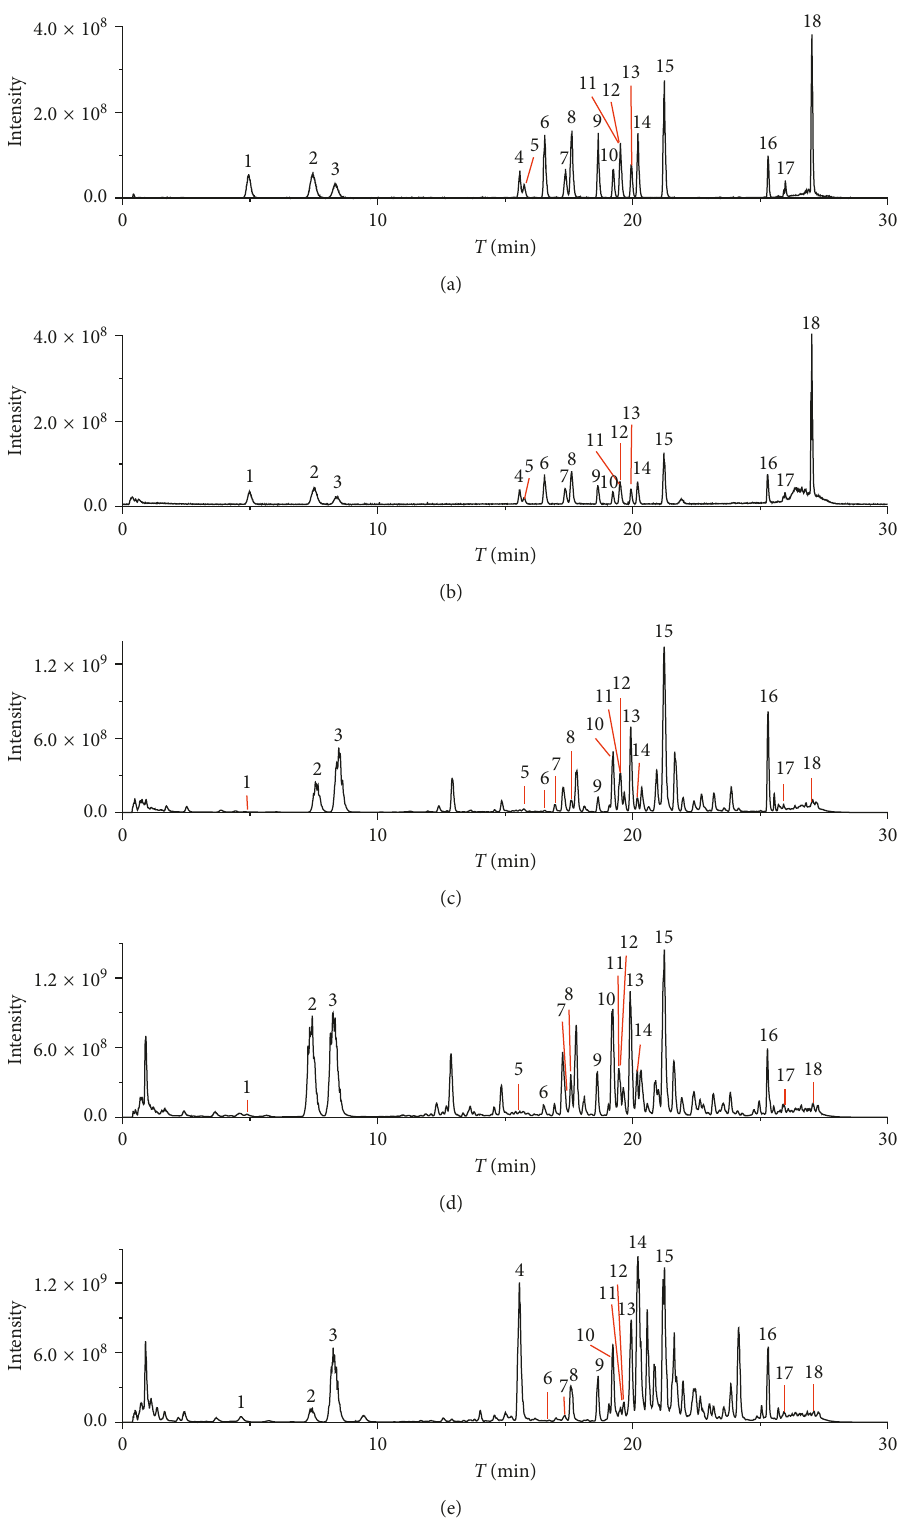
Figure 1: Total ion current chromatograms of eighteen ginsenoside standards based on (a) ion current chromatograms of (c) FGLS, (d) CGLS and (e) AMGLS based on ginsenoside Re; 4 pseudoginsenoside F11; 5 ginsenoside Rf; 6 notoginsenoside R2; 7 ginsenoside Rh1; 8 ginsenoside Rg2; 9 ginsenoside Rb1; 10 ginsenoside Rc; 11 ginsenoside F1; 12 ginsenoside Ro; 13 ginsenoside Rb2; 14 ginsenoside Rb3; 15 ginsenoside Rd; 16 ginsenoside F2; 17 ginsenoside Rg3; 18 ginsenoside